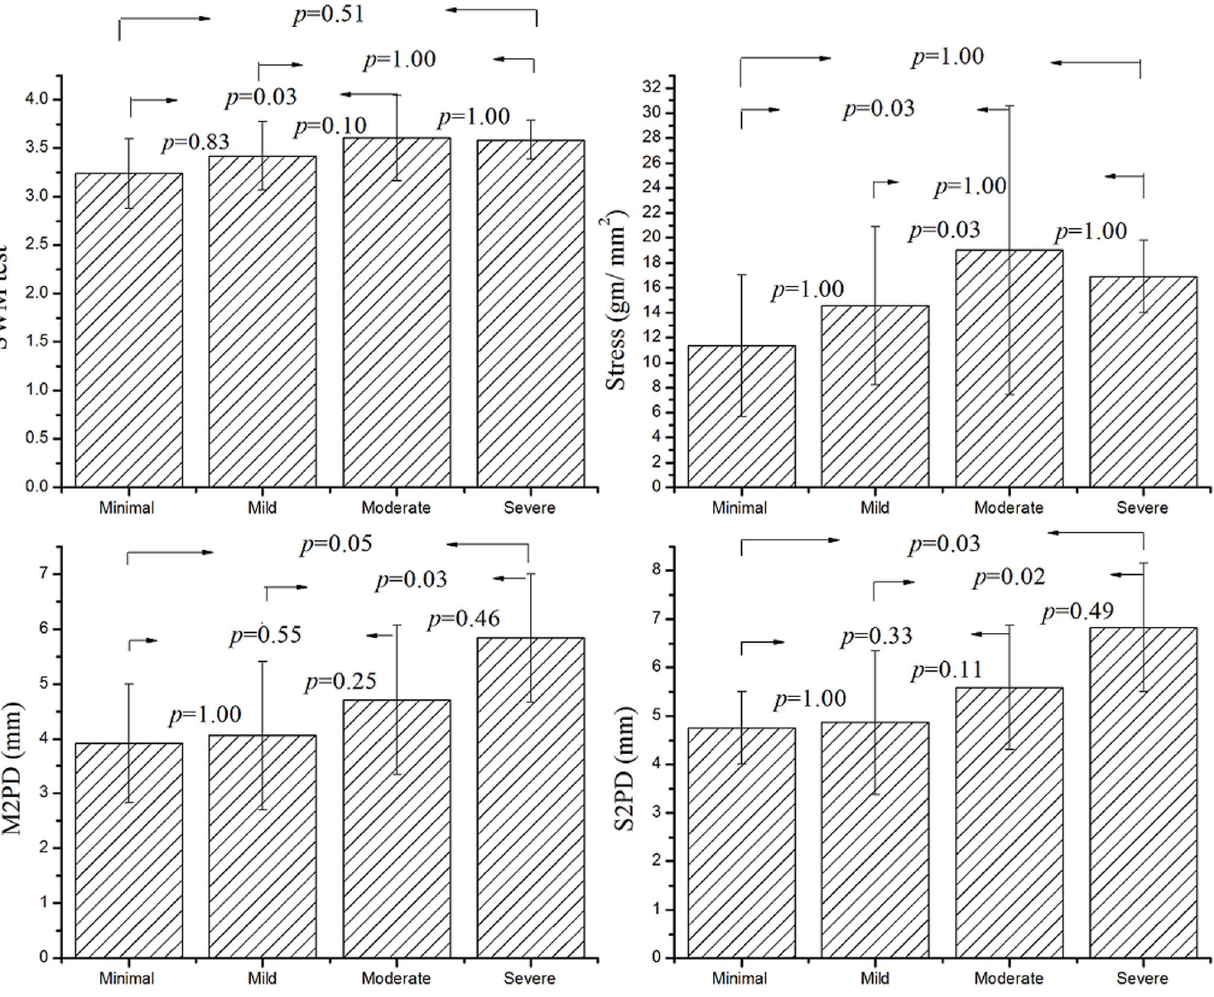
Figure 3. Mean ( 6 SD) of SWM, M2PD, S2PD and stress determined from SWM result for various grades of CTS severity based on nerve conduction study. The difference in all of the traditional sensibility tests between each pair of the CTS subgroups did not reach statistical significance. (Statistical analysis method: the mixed effect model with Bonferroni multiple comparisons test; the significance threshold analyses for Bonferroni post hoc test was set at p